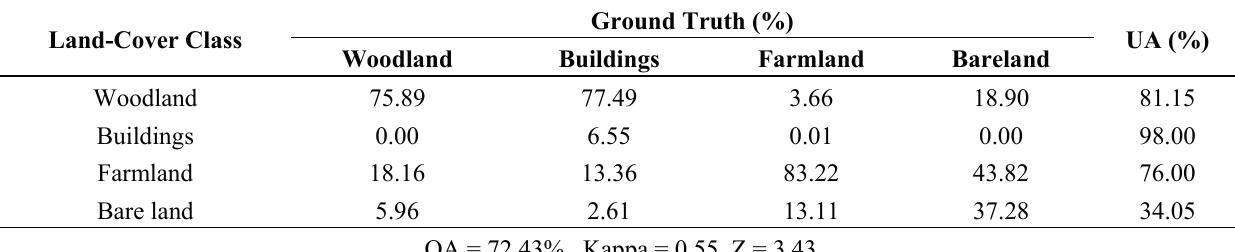
Table 5. The accuracy evaluation of the supervised classification result with the P-HH polarized image. Land-Cover Class